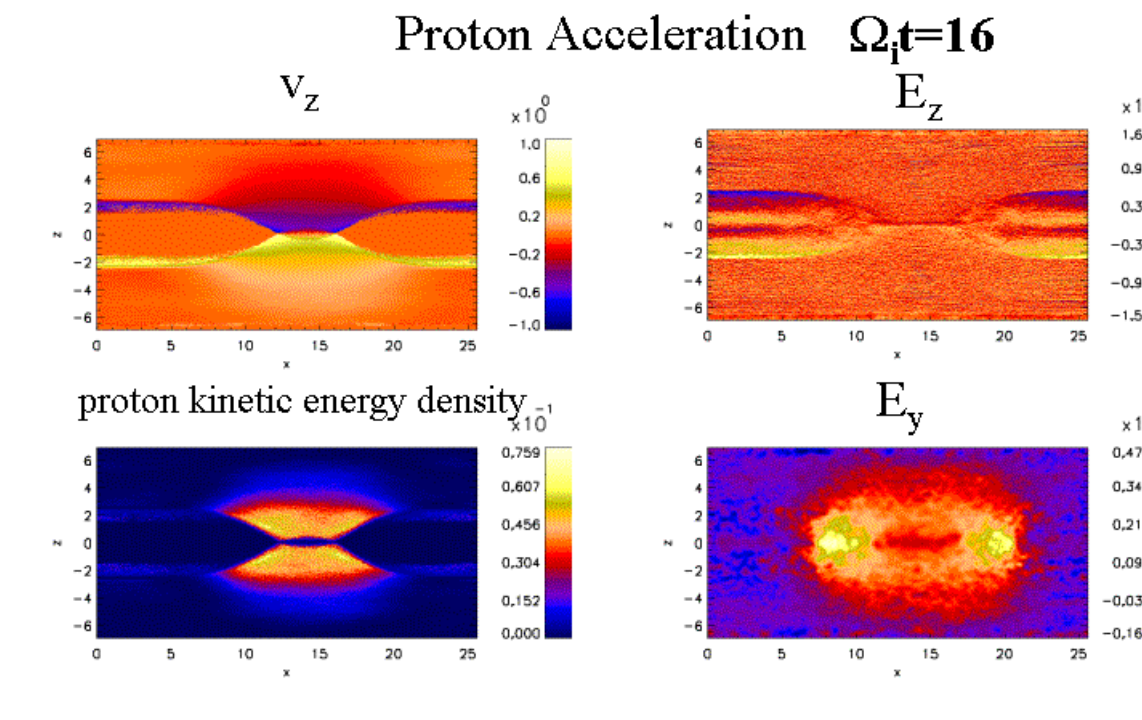
Fig. 7. Background proton acceleration, in the same format as Fig.